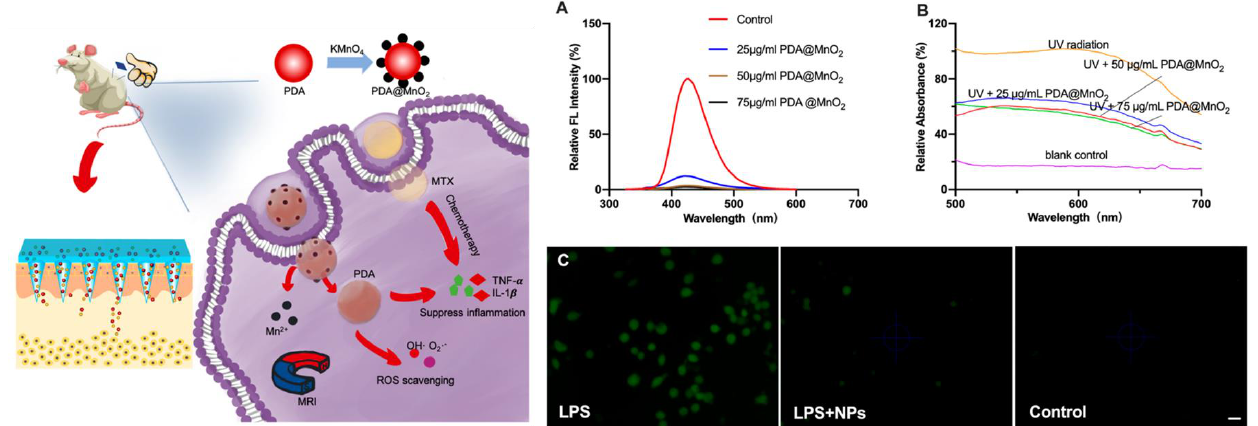
Figure 7. Schematic illustration of the synthesis of a high-performance nanozyme of PDA@MnO 2 and the fabricated microneedles successfully delivered drugs with nanocomposites, as shown by results in paw swelling, MRI Image, and the level of cytokine. ( A ) scavenging efficiencies of OH • and ( B ) O 2 •− with PDA@MnO 2 . ( C ) ROS levels in the LPS-treated RAW264.7 cells with or without PDA@MnO 2 treatment (control is without LPS and PDA@MnO 2 ) detected by fluorescence images. Reprinted with permission from ref. [110].